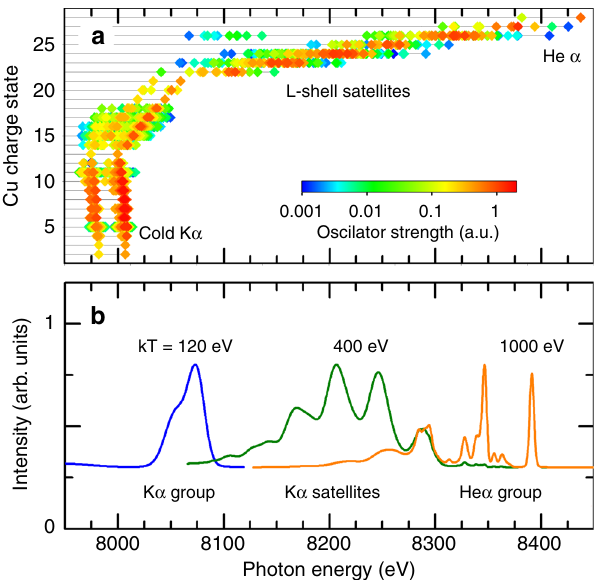
Fig. 9 Atomic transitions. a Energies of K-shell transitions in various ionization states of Cu as calculated by the FAC code. b Synthetic single- cell spectra for different